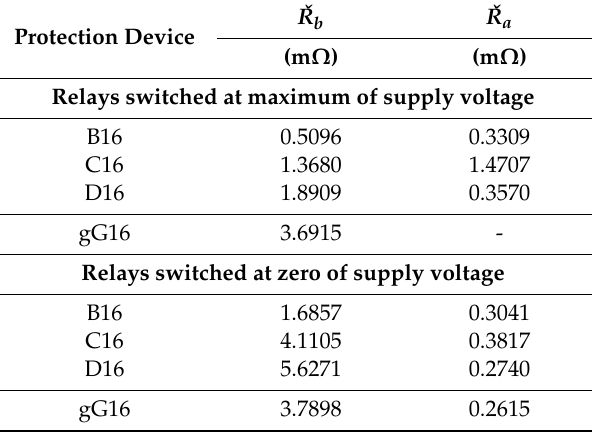
Figure 5. Change in contact resistance under the influence of switching of a short-circuit current at voltage phase: ( a ) Φ = 0°, ( b ) Φ = 90°; P , relay with full rivets. Table 4. Mean values of the contact resistance for relays switched on at zero and maximum of supply voltage, before and after the trial: Ř b , mean value of contact resistance before the trial; Ř a , mean value of contact resistance after the trial.